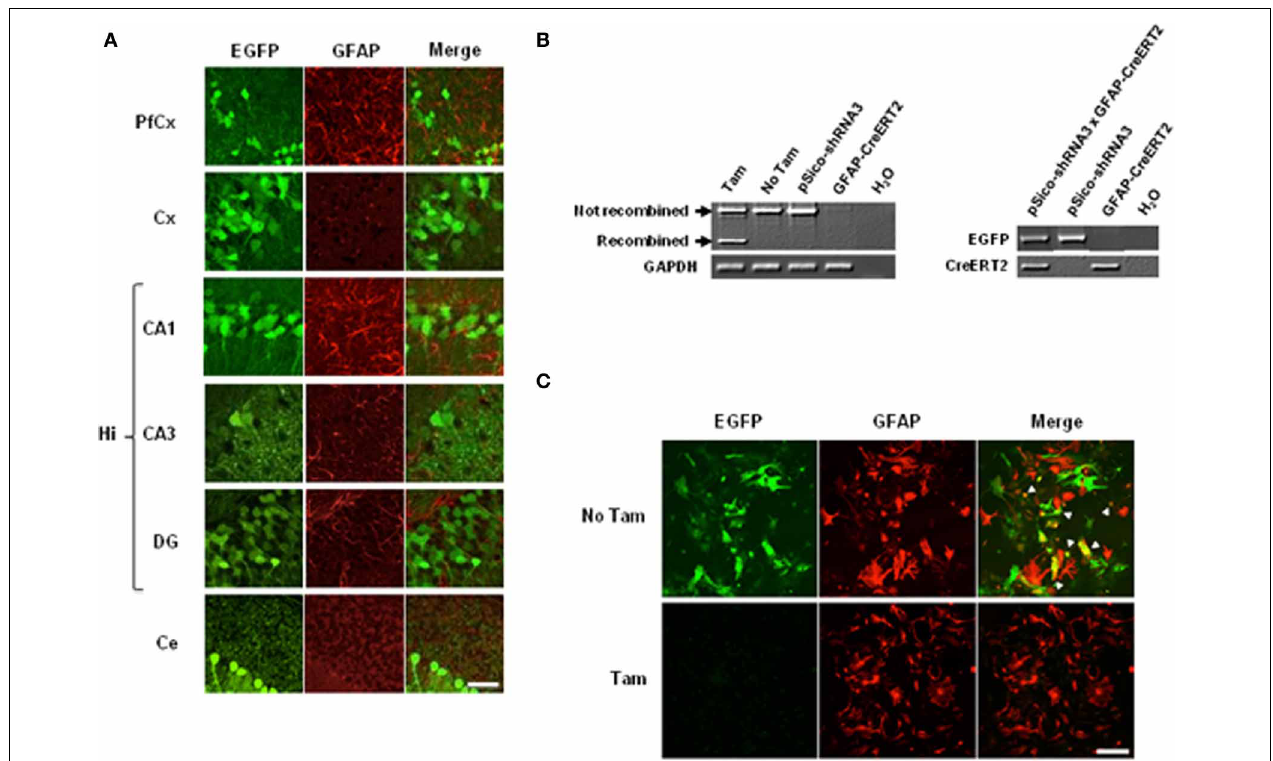
FIGURE 5 | Cre-mediated recombination in astrocytes and neurons. (A) Immunohistochemical analysis of EGFP expression in tamoxifen- treated pSico-shRNA3 × GFAP-CreERT2 mice. EGFP (green) and GFAP (red) co-immunostaining in prefrontal cortex (PfCx), cortex (Cx), hippocampus (CA1, CA3, DG), and cerebellum (Ce). Scale bar: 40 μ m. (B) PCR showing Cre-mediated recombination (left panel) in pSico-shRNA3 × GFAP-CreERT2 primary astrocytes by